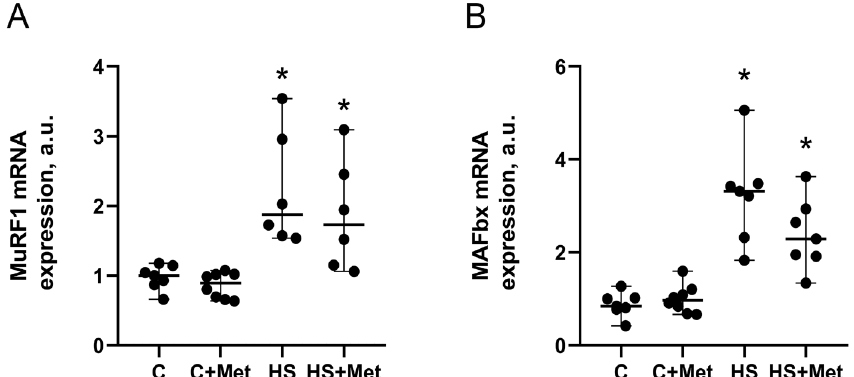
Figure 11. Effect of metformin pre-treatment on muscle RING finger 1 (MuRF1) ( A ) and muscle atrophy F-box (MAFbx/atrogin-1) ( B ) mRNA expression levels in rat soleus muscle. C, vivarium control, C+Met, vivarium control + metformin pre-treatment, HS, 7-day hindlimb suspension, HS+Met, metformin pre-treatment + 7-day hindlimb suspension. Scatter dot plots indicate median values, and the whiskers represent minimum and maximum values; n = 6–8/group. *: p < 0.05 vs. C. Ubiquitin mRNA expression significantly increased by 105%, 454%, and 247% ( p < 0.05) in the C+Met, HS, and HS+Met groups, respectively, compared to the control group (Figure 12). In the HS+Met group, ubiquitin mRNA expression significantly decreased by 207% ( p < 0.05) relative to the HS group (Figure 12).